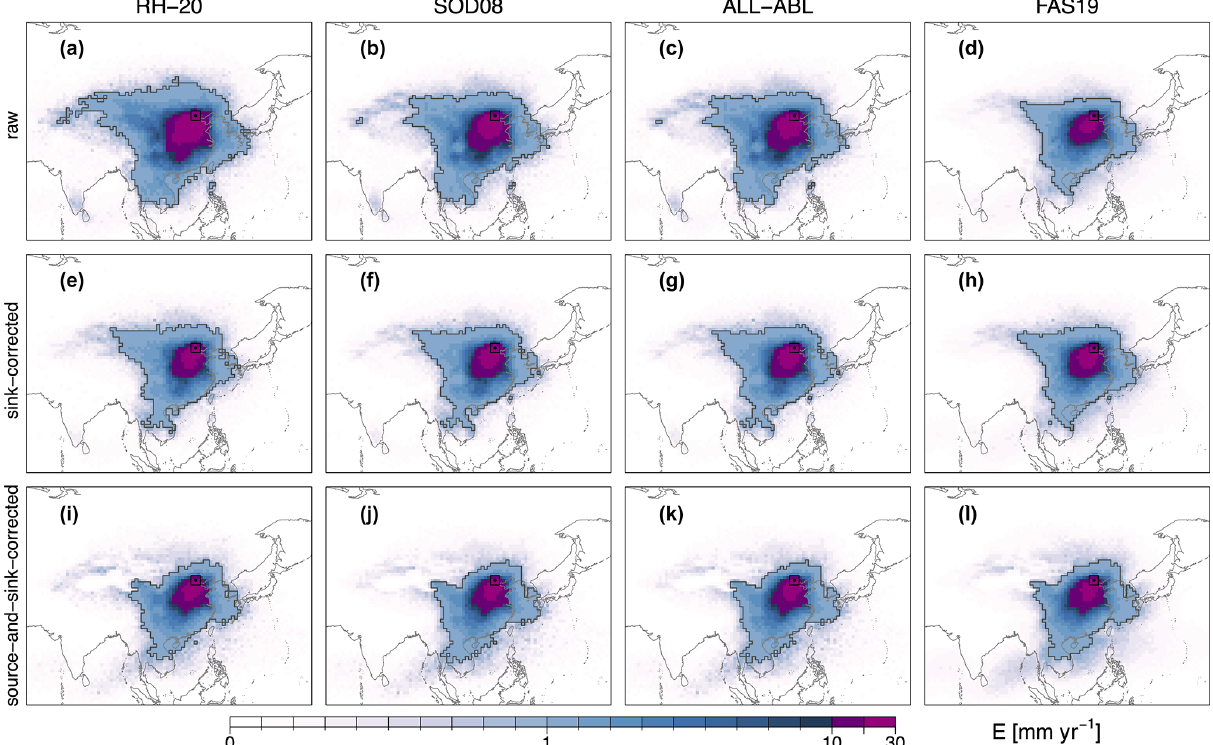
Figure 8. Source regions of precipitation for Beijing and its surroundings, as shown by varying the detection criteria for E (along columns) and the bias correction methods (along rows) as estimated with linear discounting of losses en route and linear attribution. Along the columns, the following E criteria are employed: RH-20 (a, e, i) , the SOD08 criteria (b, f, j) , the ALL-ABL criteria (c, g, k) , and the FAS19 criteria (d, h, l) . Along the rows, the following bias correction methods are employed: no bias correction (a–d) , sink bias correction using P (e–h) , and a source and sink bias correction using E and P (i–l) . The dark grey lines mark the 1mm source regions, i.e., all contributions larger than 1mmyr − 1 . The black dot and the surrounding box mark Beijing and the 3 ◦ × 3 ◦ sink region. All source regions are averaged over the period 1980–2016. Note that the color scale is